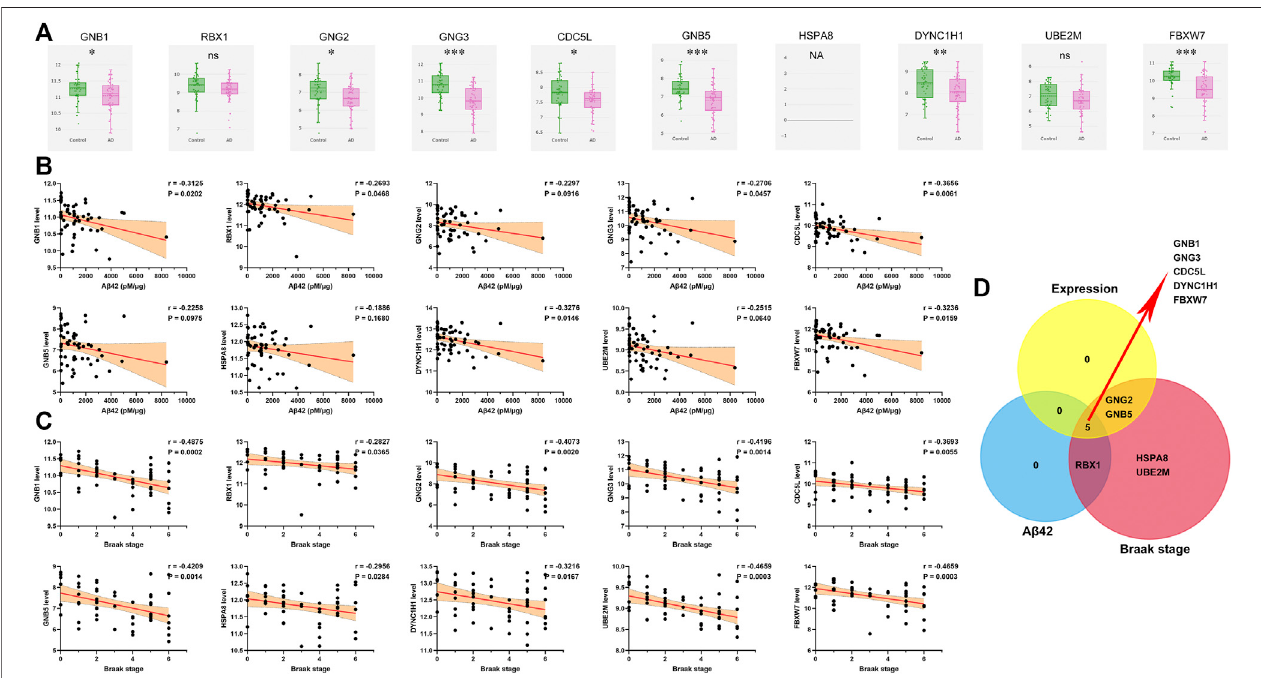
FIGURE8 | Validationofthe hub genes (A) Expression levels ofhub genes inAD and controlsfrom AlzDatadatabase (B) Pearson correlation analysiswas used to evaluate the association between and A β 42 level and hub gene expression level in expression dataset 3 (C) Pearson correlation analysis was used to evaluate the association between and Braak stage and hub gene expression level in expression dataset 3 (D) Venn diagram analysis. NA, data are not available; ns p > 0.05, * p < 0.05, ** p < 0.01, *** p < 0.001.